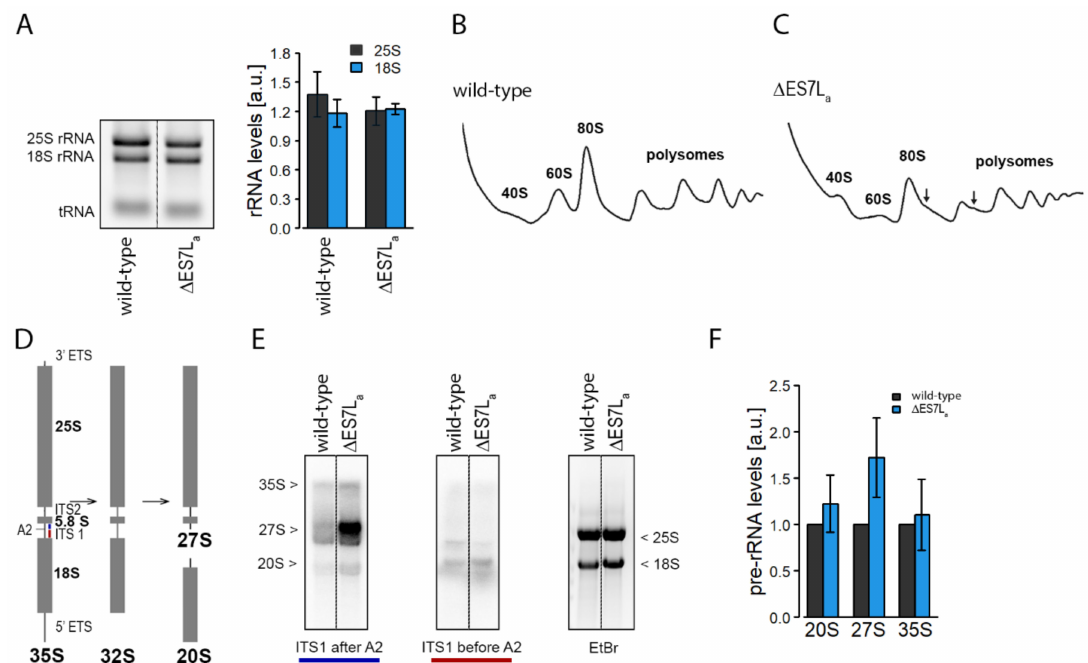
Figure 2. ∆ ES7La changes ribosome maturation and 60S levels. ( A ) Relative 18S and 25S rRNA levels (normalized to tRNA) of the different strains as deducted from gel electrophoresis of total RNA isolated from equal cell numbers (left). Mean ± standard deviation of three biological replicates is shown (right). ( B , C ) Polysome profiles of wild-type ( B ) and ES7L a deletion strains ( C ). “Halfmer” polysomes (arrows) occur in the ∆ ES7L a strain. ( D , F ) 20S, 27S and 35S pre-rRNA were tracked by northern blot probes annealing before and after A2 cleavage within ITS1 ( D ). The bands in the northern blot ( E ) were normalized to the mature rRNA bands of the gel (EtBr) and finally to wild-type levels. The mean ± standard deviation of the relative pre-rRNA levels of three biological replicates are shown ( F